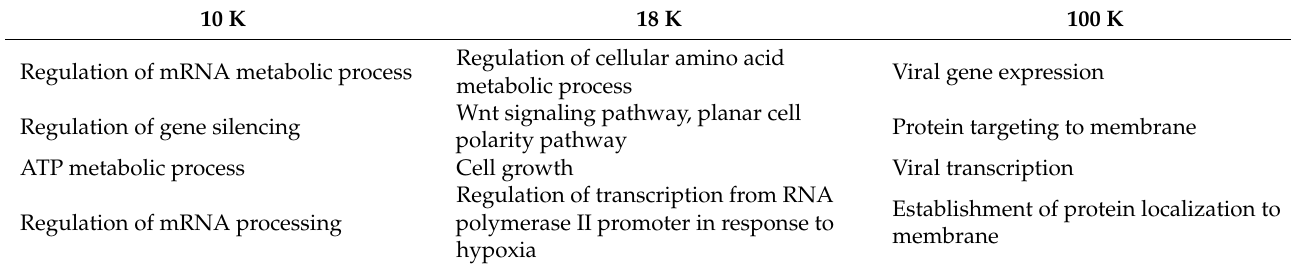
Table 4. Biological processes exclusive to each EV